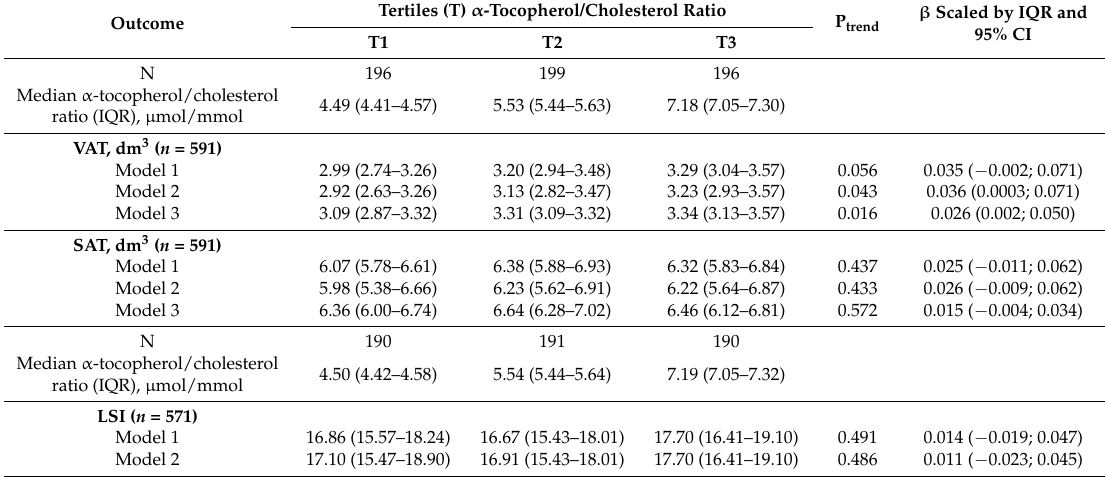
Table 3. Multivariable-adjusted means and 95% CI of VAT, SAT, and LSI according to tertiles of α -tocopherol/cholesterol ratio, and scaled by